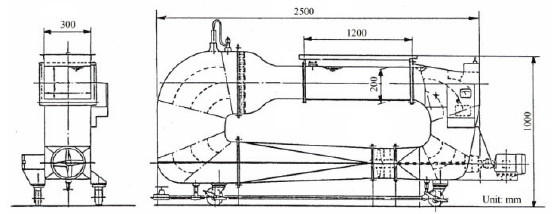
Fig. 1. Schematic diagram of closed circuit water channel